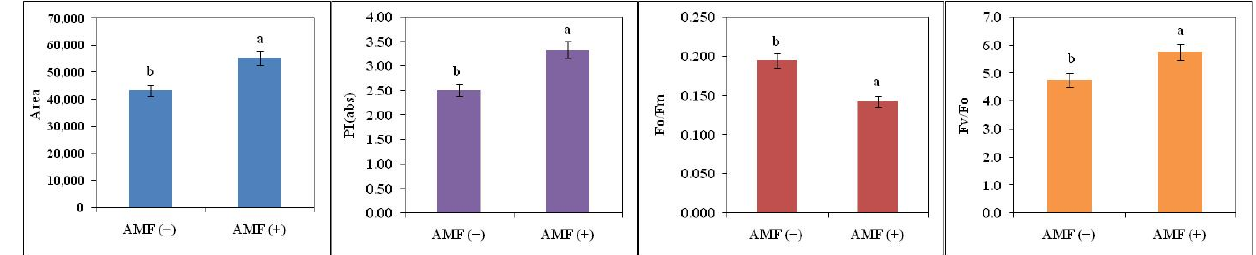
Figure 6. Fluorescence area , performance index (PI), Fo/Fm and Fv/Fo of non ‐ inoculated AMF ( − ) and inoculated plants AMF (+) of soybean. The vertical bar indicates ± SE for the mean. The means for each main treatment followed by the different letters are significantly different ( p ≤ 0.05).